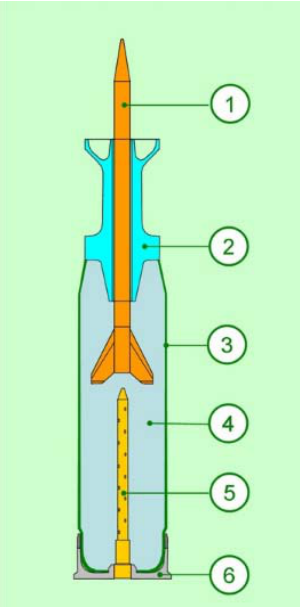
Figure 1. Main components of APFSDS ammunition [2]